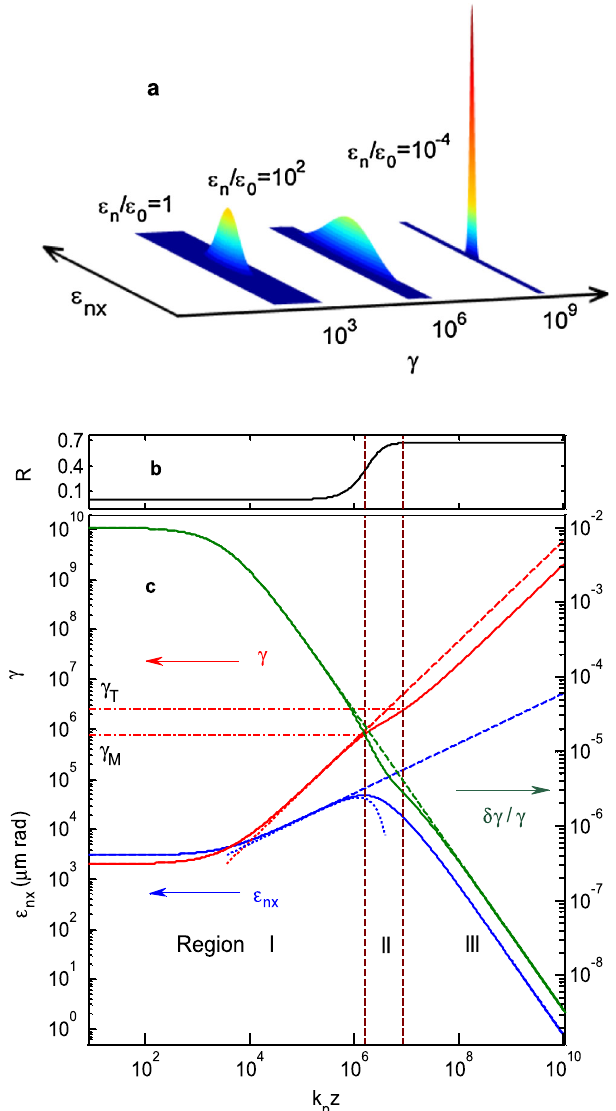
FIG. 1. (a) Depiction of the radiative self-cooling process. (b), (c) Relative radiation loss rate R and electron beam dy- namics on beam energy (cid:8) , relative energy spread (cid:11)(cid:8)=(cid:8) , in the plasma-based and normalized transverse emittance " nx accelerators without radiative damping (dashed lines), with radiative damping (solid lines), the WKB approximation z . (dotted lines) as a function of the dimensionless distance k p The initial conditions of beam energy, normalized transverse ¼ 3000 (cid:4) m rad , (cid:8) ¼ emittance, and energy spread are " n 0 0 2000 , and (cid:11)(cid:8)=(cid:8) ¼ 0 : 01 , respectively. The accelerating ¼ 0 : 56 and the focusing constant K=k ¼ =E gradient is E z p 0 0 : 35 . The evolution of normalized transverse emittance is char- (cid:9) (cid:8) (cid:9) (cid:8) ), acterized by three energy regions: Region I ( (cid:8) M 0 (cid:9) (cid:8) (cid:9) (cid:8) (cid:9) (cid:8) ), respec- ), and Region III ( (cid:8) Region II ( (cid:8) M T T is the energy at which normalized transverse tively, where (cid:8) M is the energy at which emittance reaches the maximum and (cid:8) T the relative radiation loss rate R reaches the maximum value ¼ 2 = 3 , where the self-cooling due to betatron radiation R T